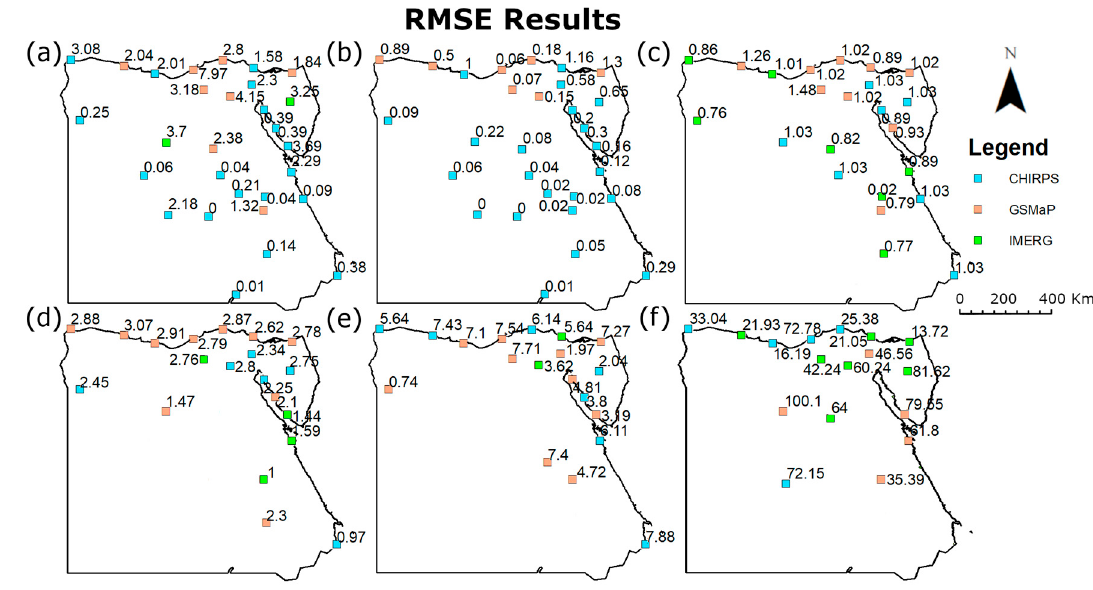
Figure 5. Maps showing the best performing datasets according to RMSE at each station along with the estimated RMSE for the best performing satellite rainfall product for ( a ) all rainfall events, ( b ) no/tiny rain, ( c ) light rain, ( d ) low–moderate rain, ( e ) heavy–moderate rain, and ( f ) heavy rain .